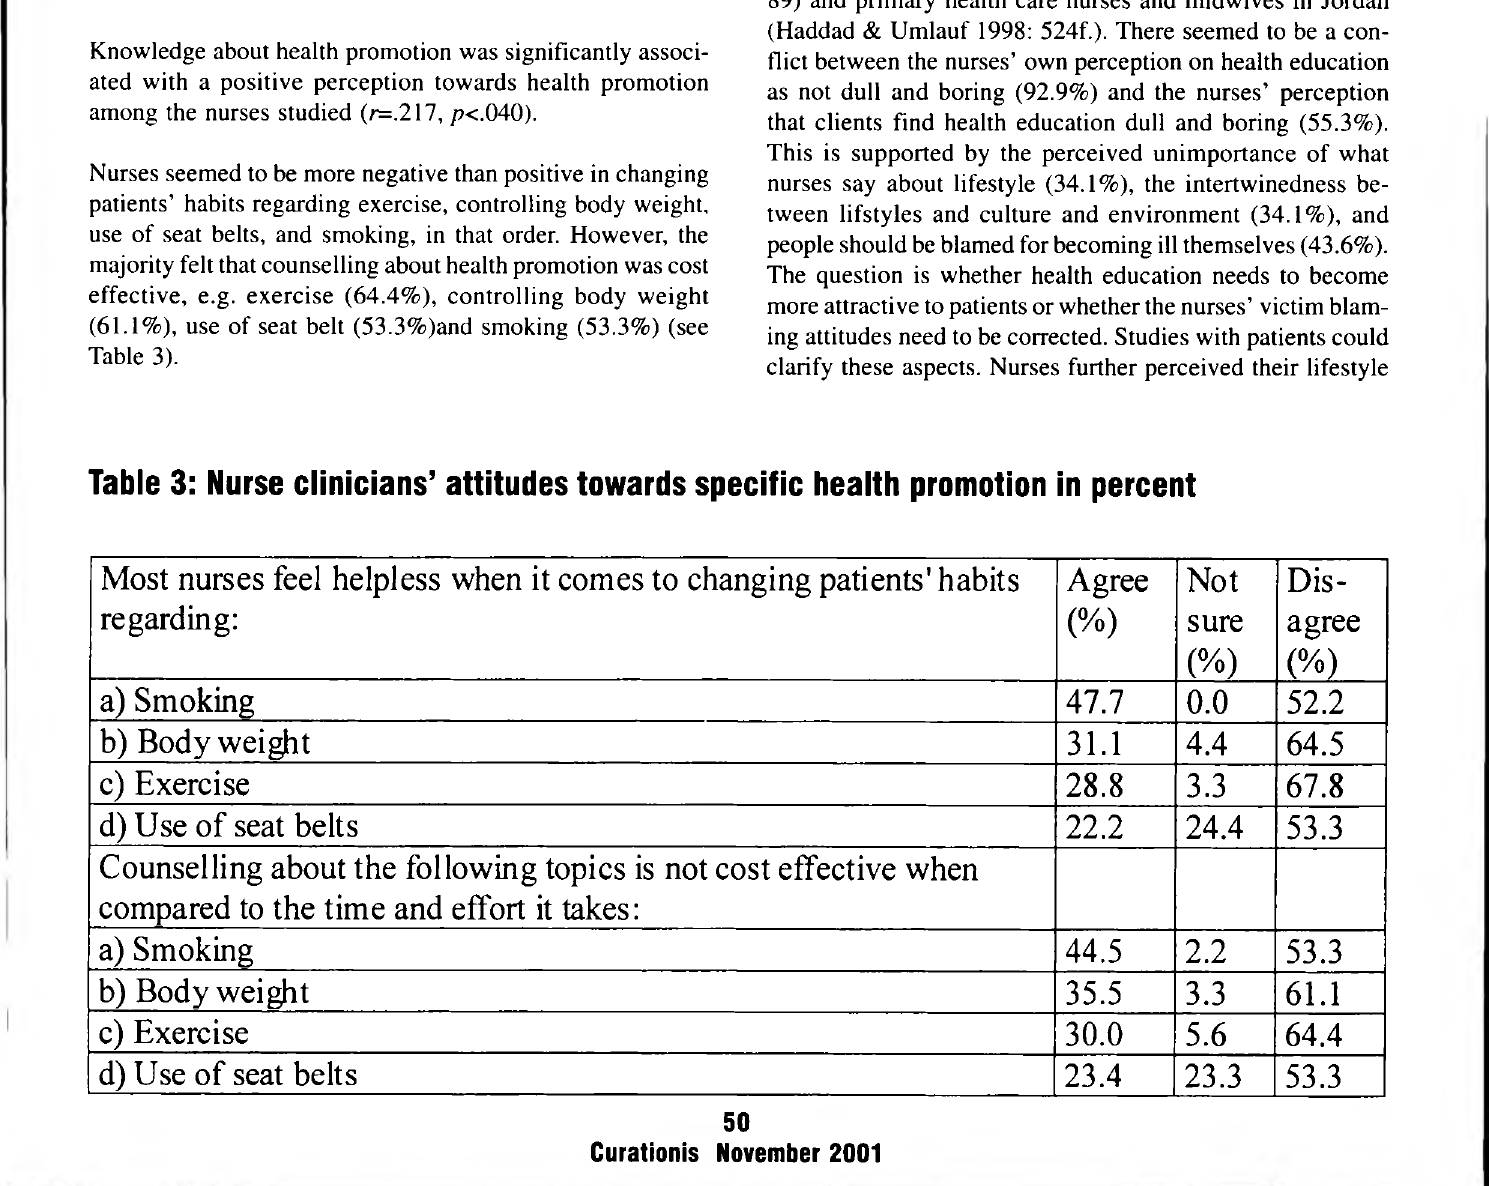
Table 3: Nurse clinicians’ attitudes towards specific health promotion in percent Most nurses feel helpless when it comes to changing patients' habits